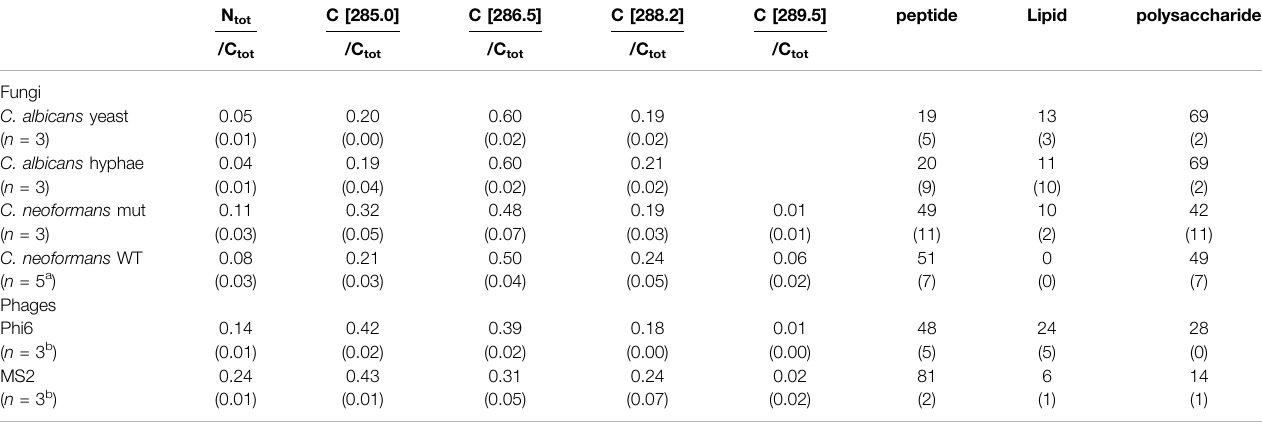
TABLE3| AverageratiosoftotalN(N tot )andC1sGL30peakshapes(BEpositioninsquareparenthesis)tototalC(C tot ),aswellaspredictedsubstancecompositionas%of total C atoms at the surface from fi tting of C1s spectra (st dev in parenthesis). N